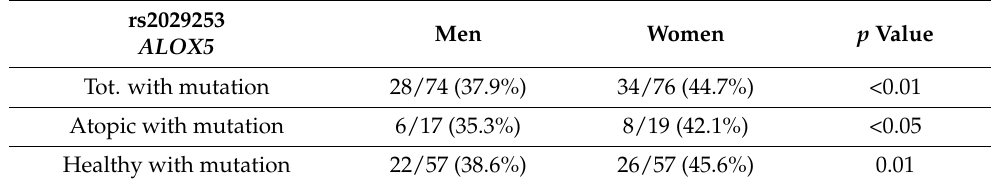
Table 2. Frequency of mutation in atopic and healthy M and W according to genotype ALOX5 rs2029253 polymorphism. The statistical tests used in these analyses were the one-way analysis of variance followed by the Tukey Multiple Comparison